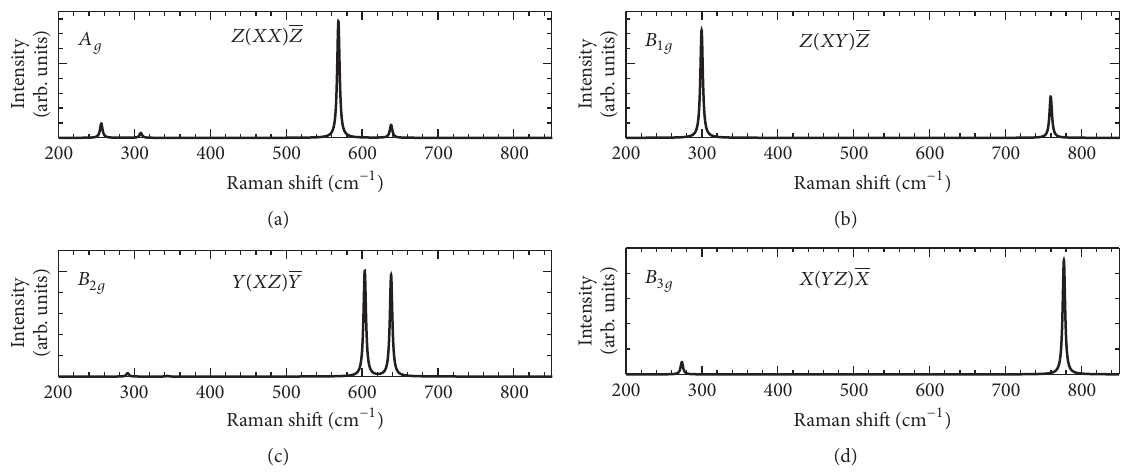
Figure 5: Backscattering Raman spectra of TiB crystal calculated at scattering geometries (a) 𝑍(𝑋𝑋)𝑍 , (b) 𝑍(𝑋𝑌)𝑍 , (c) 𝑌(𝑍𝑋)𝑌 , and (d) 𝑋(𝑌𝑍)𝑋 . Spectra are simulated at 300 K and with laser excitation wavelength of 532 nm. Peaks are represented by Lorentzian functions with artificial FWHMs of 2 cm −1 .